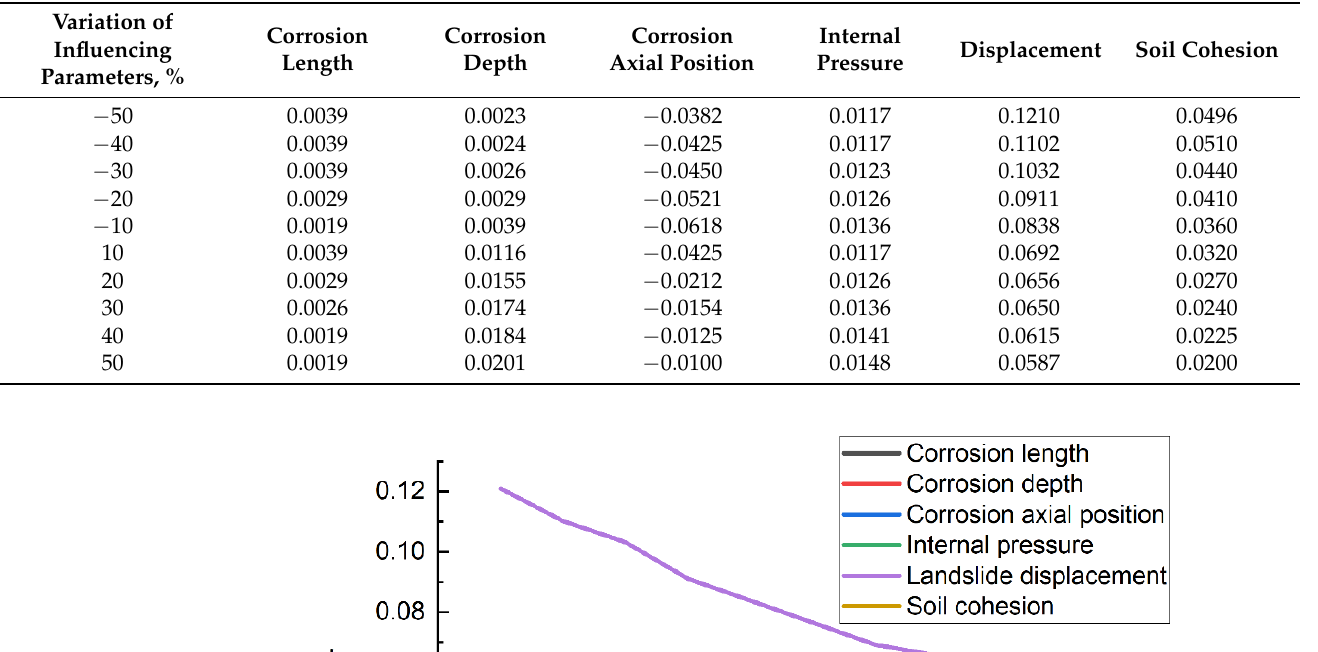
Table 11. Sensitivity coefficients for various influencing factors.